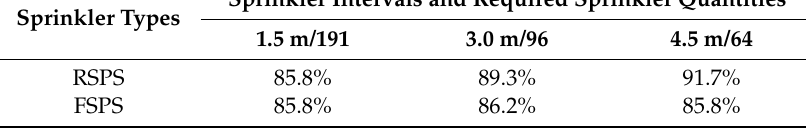
Table 7. Christiansen coefficients of uniformities ( CUCs ) for the full circular irrigated area for the simulated center pivot irrigation